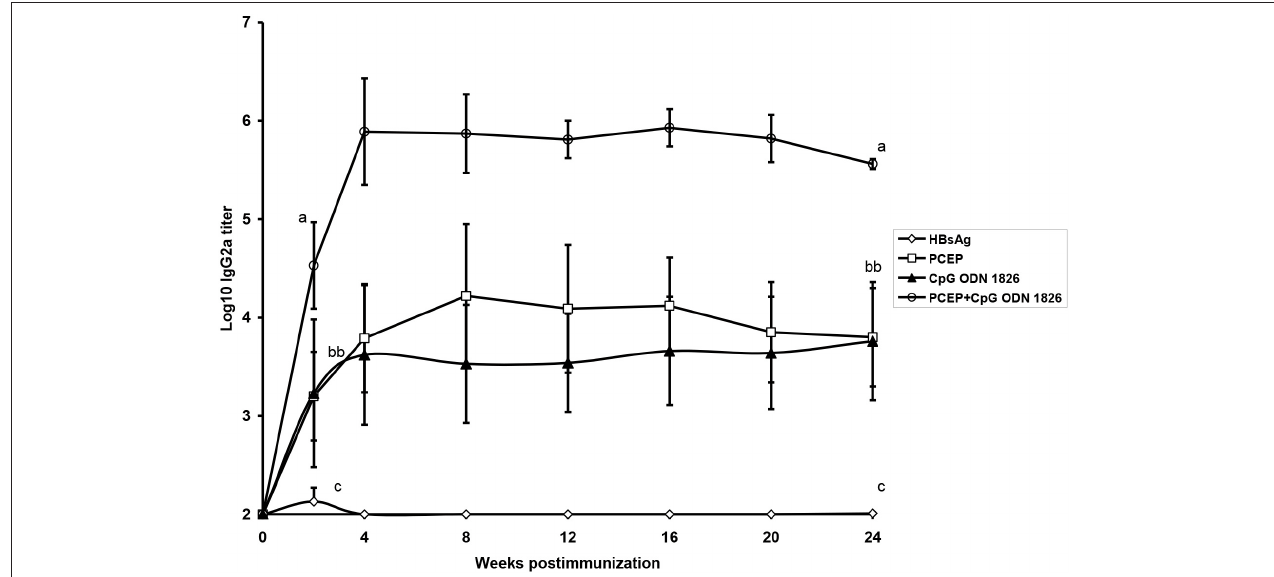
FIGURE 4 | Serum HBsAg-specific IgG2a antibody titers in mice given a single SC immunization with a dose of 0.2 _g of HBsAg alone, HBsAg + PCEP, HBsAg + CpG or HBsAg + PCEP + CpG. Each data point represents mean ± S.E.M. of titers of anti-HBsAg as determined by ELISA. Groups with different letters are significantly different ( p < 0.05) (reprinted from Mutwiri et al., 2008, Copyright 2007, with permission from Elsevier)